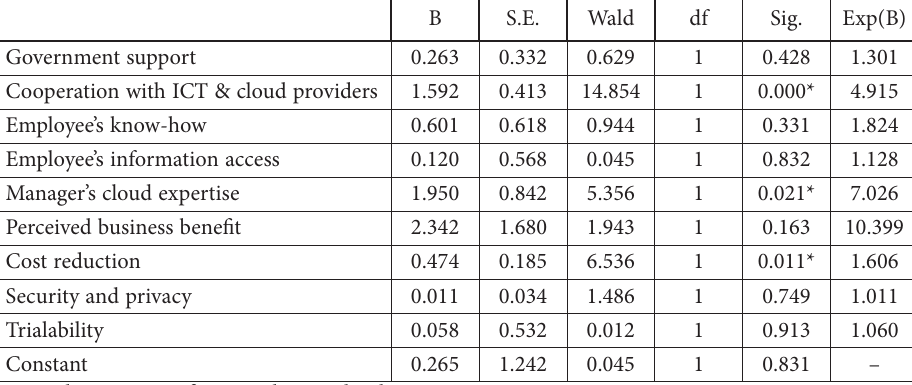
Table 17. Results of the logistic